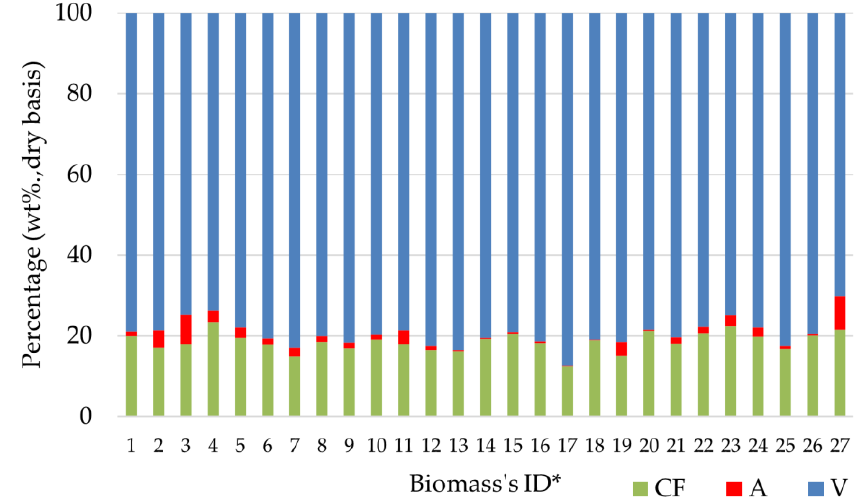
Figure 2. Results of proximate analysis for Amazonian biomasses shown in Table 3 (wt. %, dry basis). * Biomass identification.